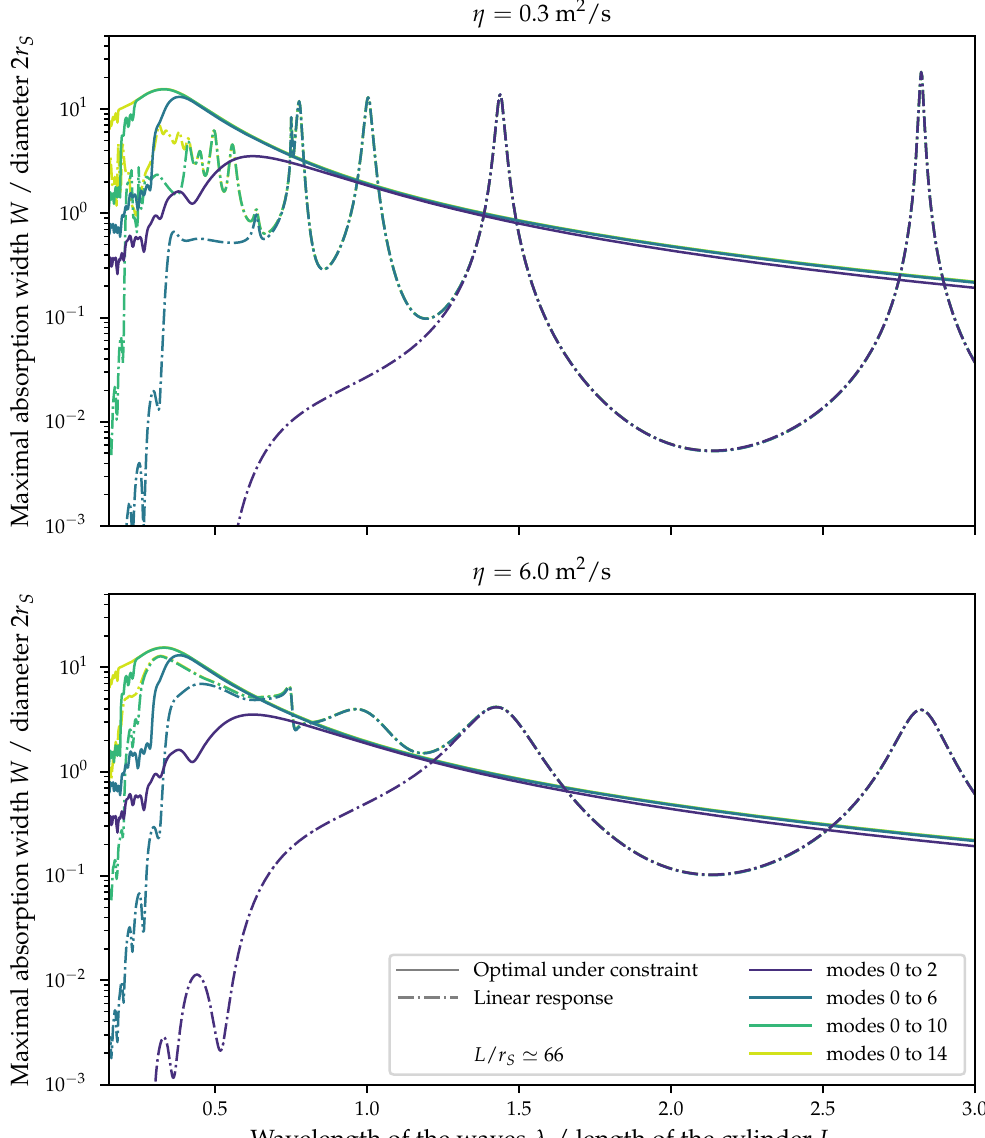
Figure 9. Dimensionless absorption width as a function of the wavelength of the incoming waves for the optimal deformation under constraint and the linear response for two values of η . The solid lines represent the constrained maximal absorption widths. The dash-dotted lines correspond to the linear